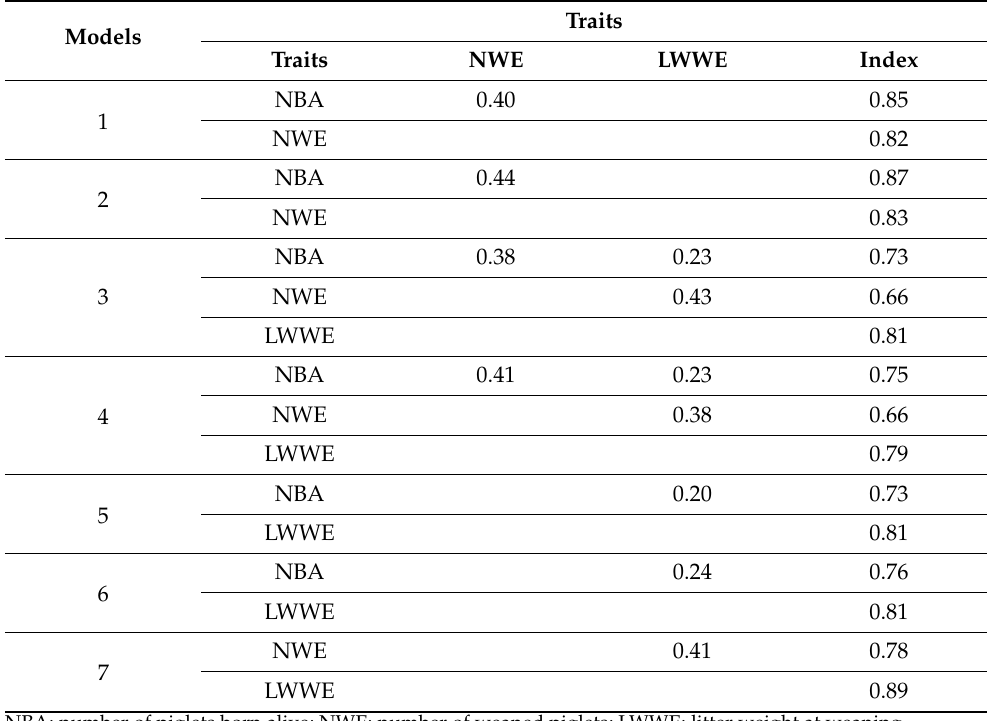
Table 12. Genetic correlation coefficient (Pearson’s correlation) between examined traits and the selection index for F1 (Pr > |t| < 0.0001).